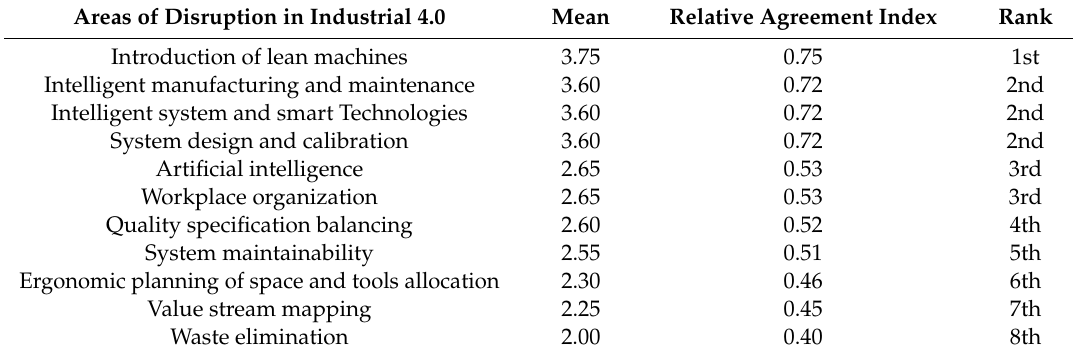
Table 5. Areas of disruptions in Industry 4.0 that influences Construction 4.0 advancement. Areas of Disruption in Industrial 4.0 Mean Relative Agreement Index